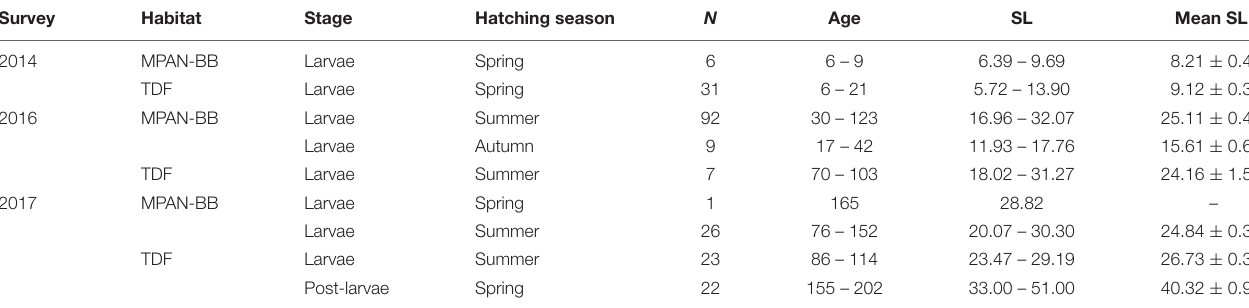
TABLE 1 | General information of Fuegian sprats Sprattus fuegensis analyzed in the Southwest Atlantic Ocean. Survey